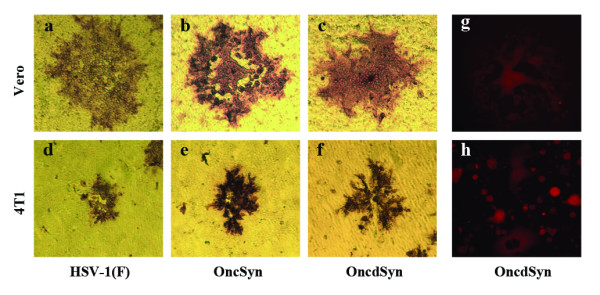
Plaque morphology of the HSV-1 (F), OncSyn and OncdSyn viruses. Nearly confluent Vero (a-c) and 4T1 (d-f) cell monolayers were infected with wild-type HSV-1(F) (a, d), OncSyn (b, e) and OncdSyn (c, f) viruses. Individual viral plaques were visualized 48 hr post infection by immunohistochemistry and photographed with a phase contrast microscope. Vero (g) and 4T1 (h) cells were infected with OncdSyn virus. Viral plaques were photographed 48 hr postinfection with a fluorescent microscope.